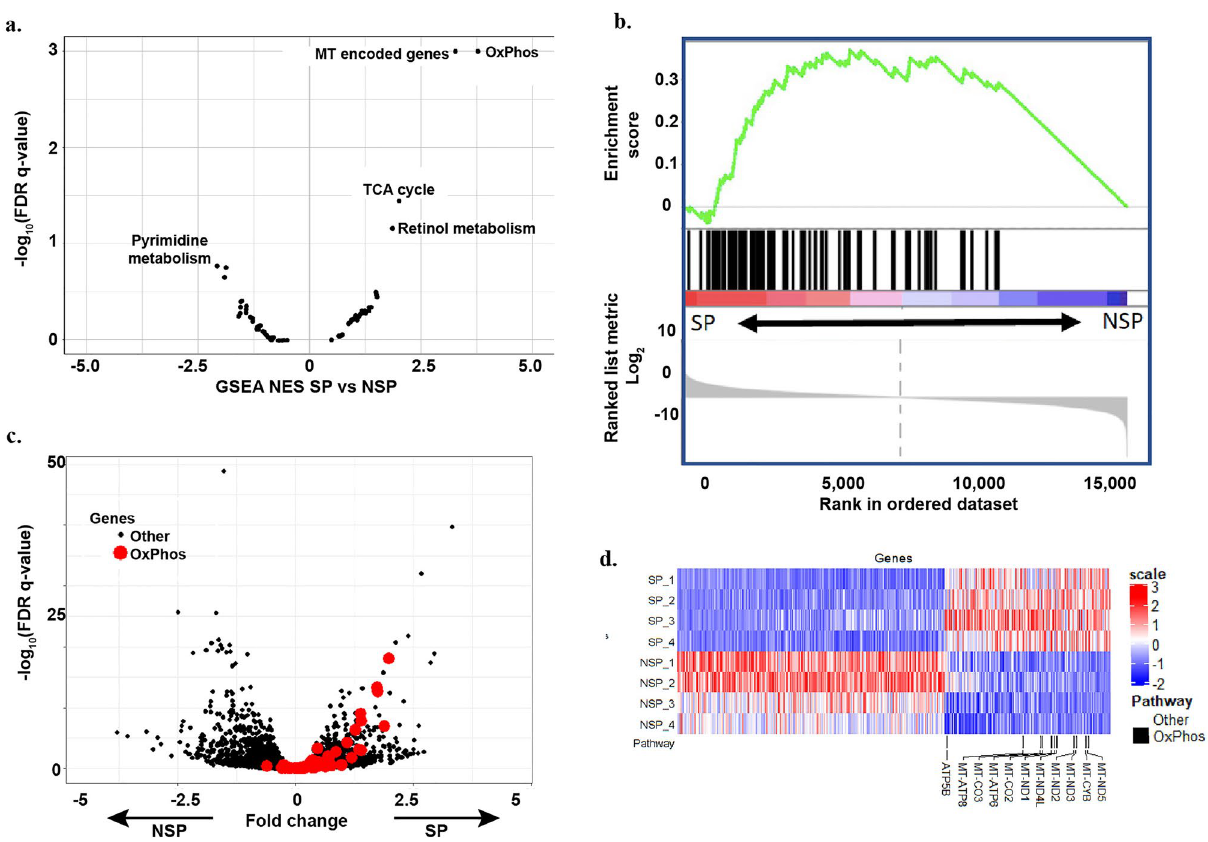
Figure 1. Gene expression in SP cells is enriched for OxPhos pathway. ( a ) Oxidative phosphorylation pathway was the most highly enriched in the KEGG metabolic pathways. ( b ) GSEA analysis demonstrated that the OxPhos gene set was significantly enriched in SP (normalized enrichment score (NES) 3.97, nominal p value < 0.0002, FDR q value < 0.0002). ( c ) Volcano plot of differential gene expression between SP and NSP cells. OxPhos genes (red) were predominantly overexpressed in SP as compared with the entire transcriptome (black). ( d ) Heatmap (Transcripts Per Million, TPM) of all significantly differentially expressed genes demonstrating OxPhos gene overexpression in SP. The heatmap was created using the Complex Heatmap package v.2.4.3 (PMID: 27207943) in R 4.0.1. https:// bioco nduct or. org/ packa ges/ relea se/ bioc/ html/ Compl exHea tmap.